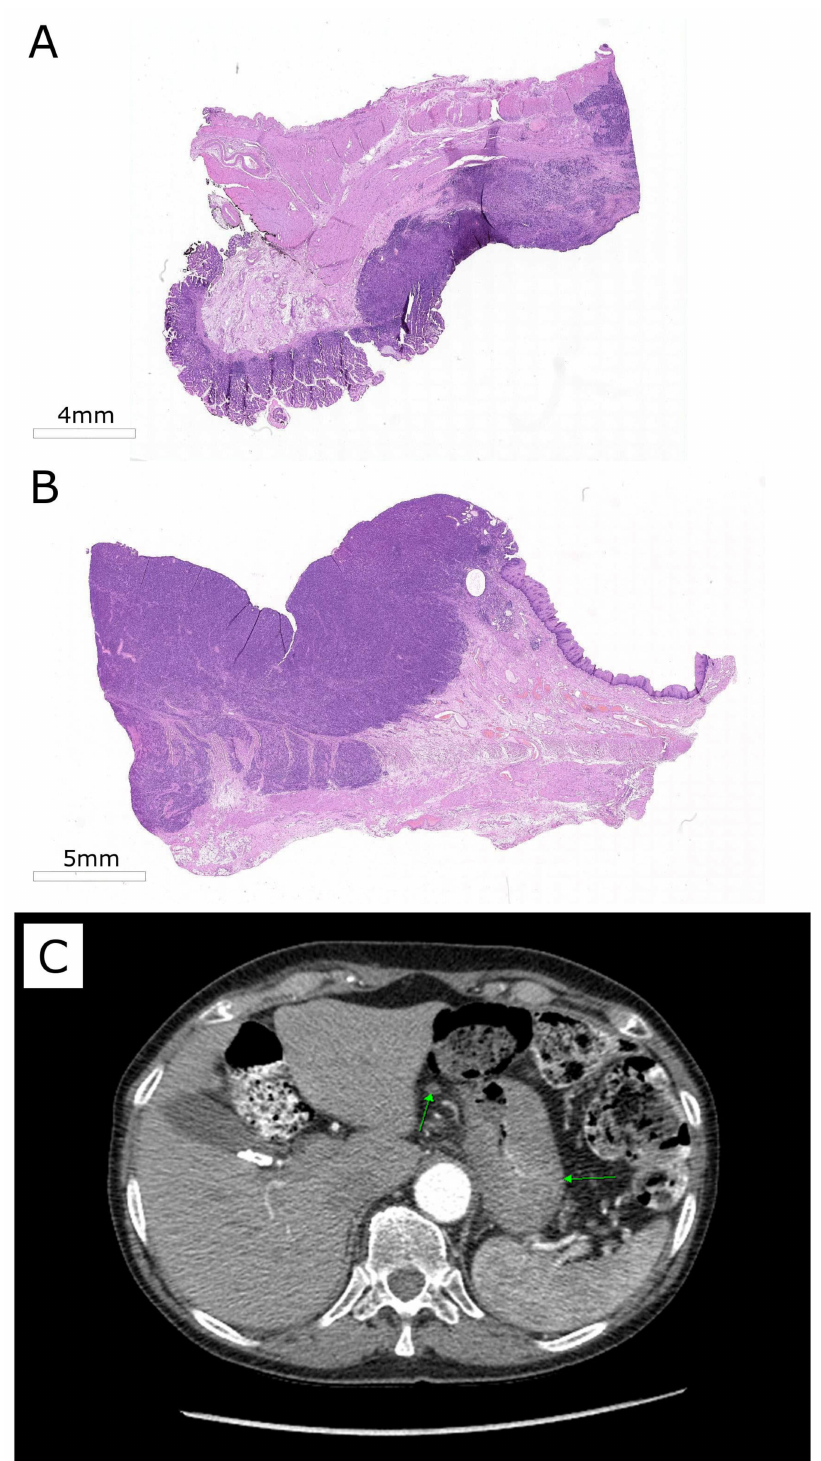
Figure 1. ( A , B ) Hematoxylin and eosin (H&E) staining shows moderately to poorly di ff erentiated adenocarcinoma. ( A ) Tumor removed from stomach. ( B ) Tumor removed from esophagus. ( C ) Baseline tumor appearance: primary gastric lesion (right arrow) and involved lymph node (left arrow). According to current guidelines, further management would be adjuvant chemotherapy (4–6 cycles of FLOT or another regimen), but the patient’s age and lack of clear benefit (downstaging)